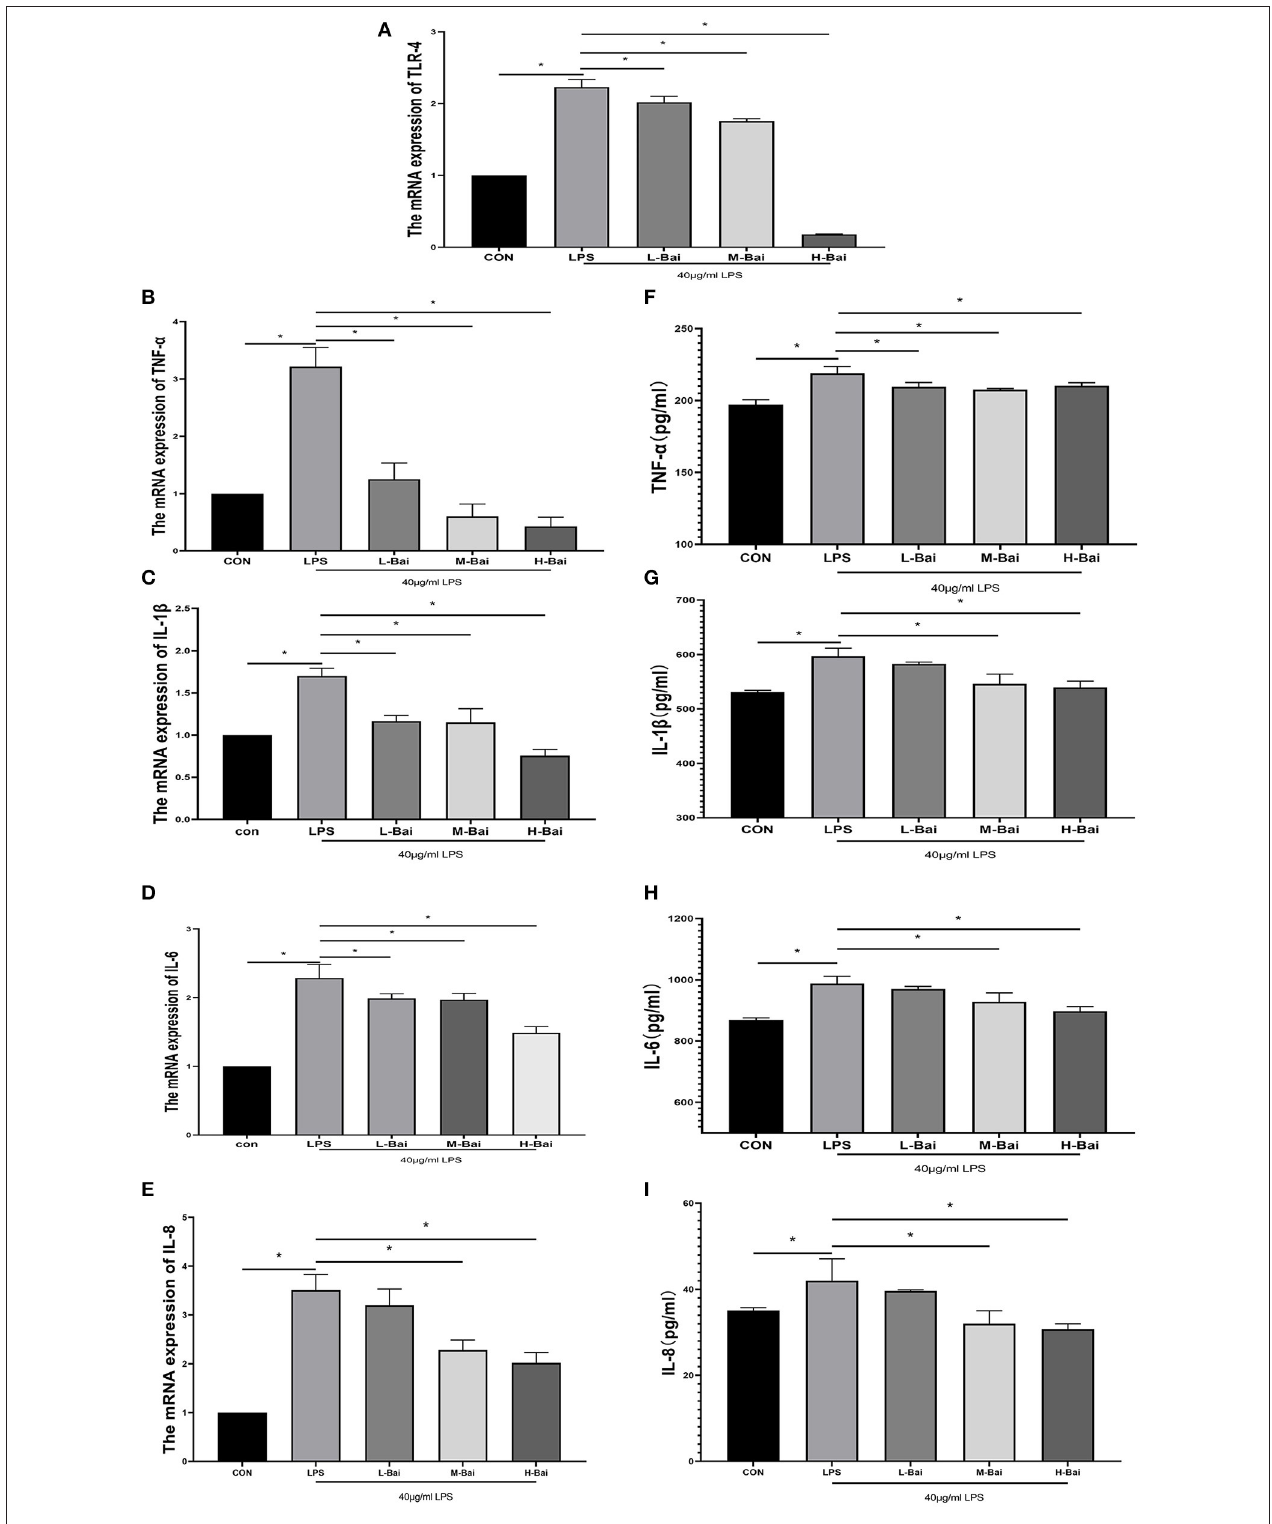
FIGURE 2 | Effects of baicalin on inflammatory factor expression in LPS-stimulated IPEC-J2 cells. Quantitative effects of baicalin on TLR4 (A) , TNF- α (B) , IL-1 β (C) , IL-6 (D) and IL-8 (E) mRNA expression in IPEC-J2 cells. Effects of baicalin on TNF- α (F) , IL-1 β (G) , IL-6 (H) and IL-8 (I) protein expression in IPEC-J2 cells. Data are presented as the mean ± SEM ( n = 3 per treatment, * p < 0.05 compared with the model group). CON, control; L-Bai, low-concentration baicalin; M-Bai, middle-concentration baicalin; H-Bai, high-concentration baicalin.